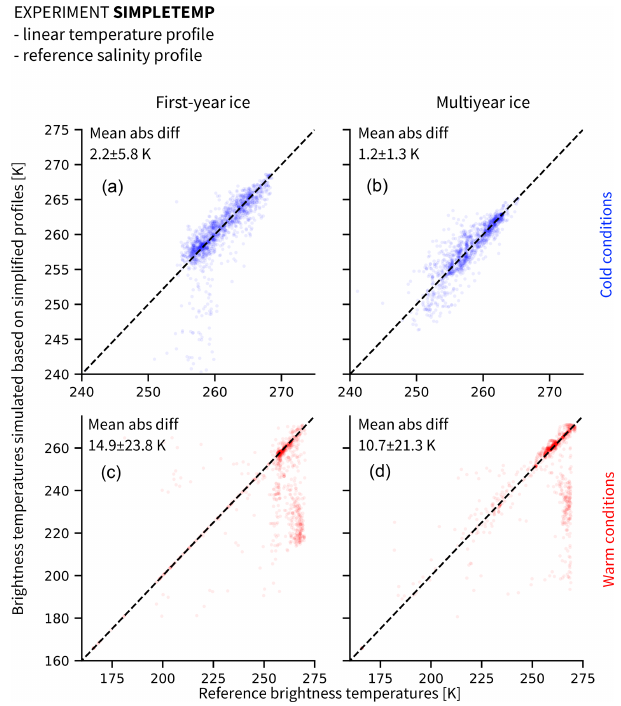
Figure 4. Brightness temperatures at 6.9GHz vertical polarization, simulated based on linear temperature profiles and reference salin- ity profiles (experiment SIMPLETEMP), as a function of reference brightness temperatures: (a, c) first-year ice and (b, d) multiyear ice in (a, b) cold conditions (October to March) and (c, d) warm conditions (April to September). Note that the axes for cold condi- tions are limited to the range between 240 to 275K for clarity. The remaining brightness temperatures are scattered between 165 and 240K and represent around 2% of the simplified data and 0.4% of the reference data.